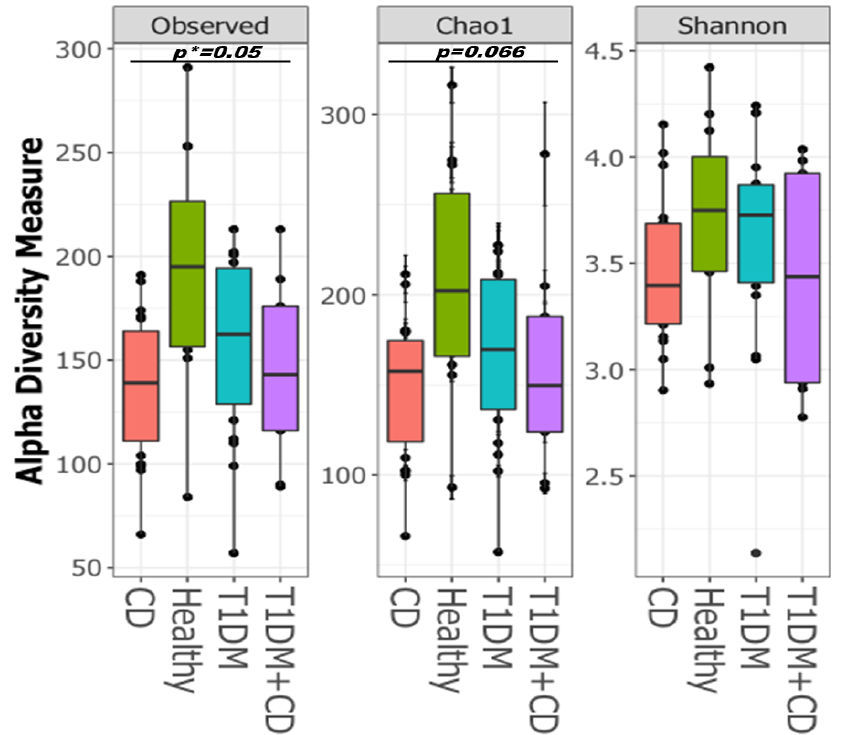
Figure 2. Boxplots of Alpha-diversity indices: Observed OTUs; Chao1; Shannon. Boxes represent the interquartile range (IQR) between the first and third quartiles (25th and 75th percentiles, respectively), and the horizontal line inside the box defines the median. Whiskers represent the lowest and highest values within 1.5 times the IQR from the first and third quartiles, respectively. Statistical significance between the sample groups CD (orange), T1DM (blue), healthy control (green), T1DM+CD (purple) was identified by the Kruskal-Wallis test with false discovery rate (FDR)-Bonferroni corrected p values. * p ≤ 0.05). Abbreviations: T1DM = Type 1 Diabetes; CD = Coeliac disease.